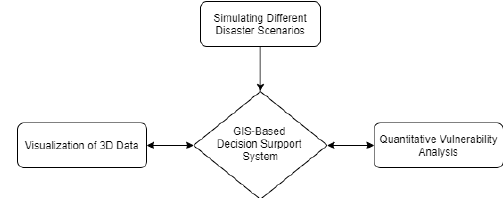
Figure 4. GIS-based decision support system